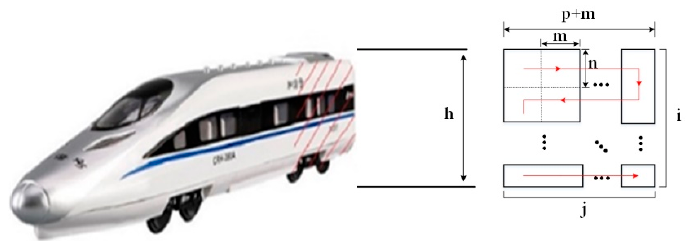
Figure 10. Schematic diagram for the trajectory planning of the robot